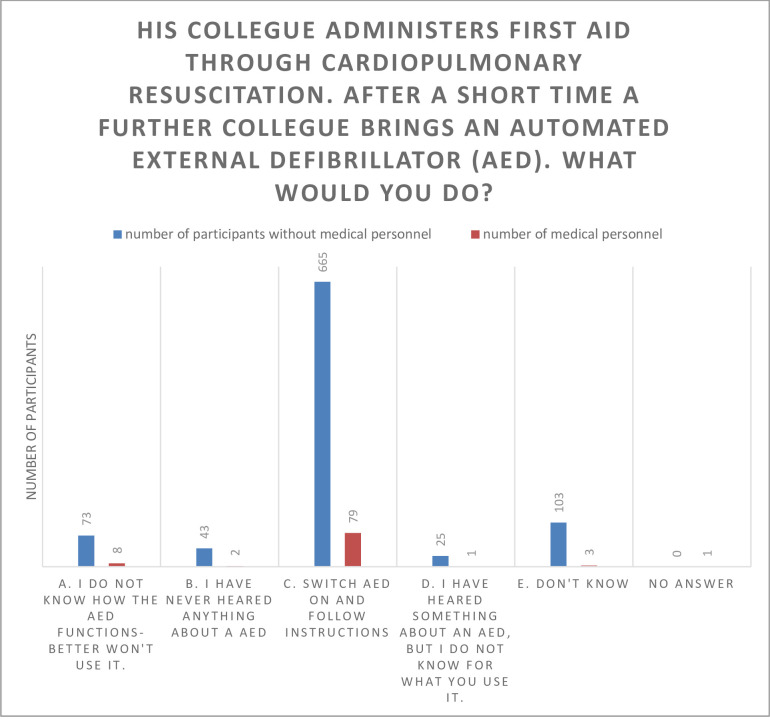
Answers given to question number 9 from medical personnel and other professions in comparison.